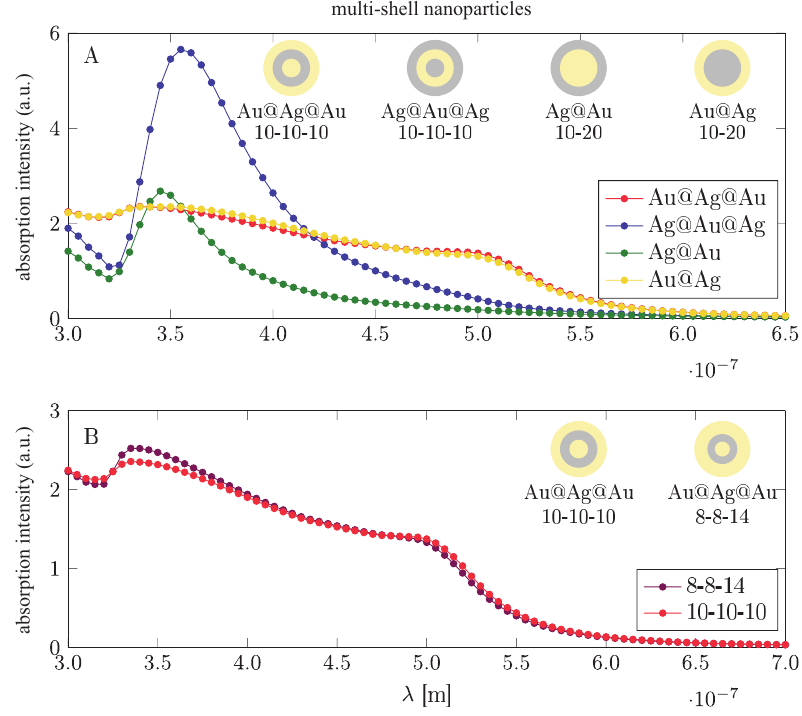
Figure 9. Flattening and elongation of the dipole surface plasmon resonance in multi-shell-core metallic nanoparticles. Thicknesses of shells are shown in nanometers [45] (Comsol simulation).